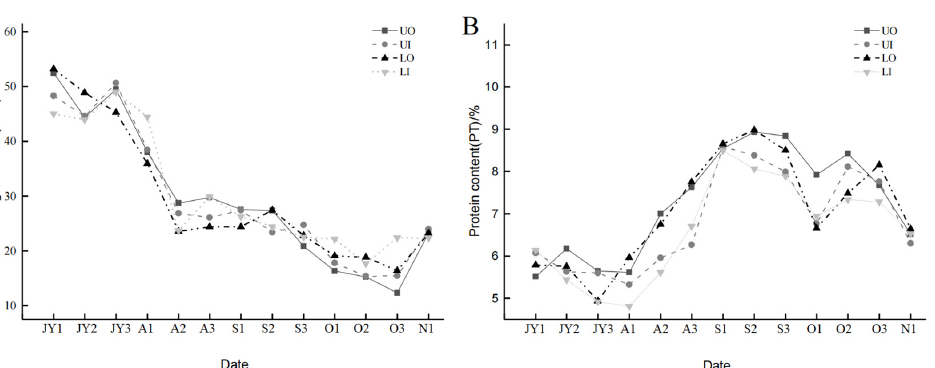
Figure 4. ( A ) Soluble sugar content and ( B ) protein content in C. oleifera ‘Huaxin’ from July 2021 to November 2021.